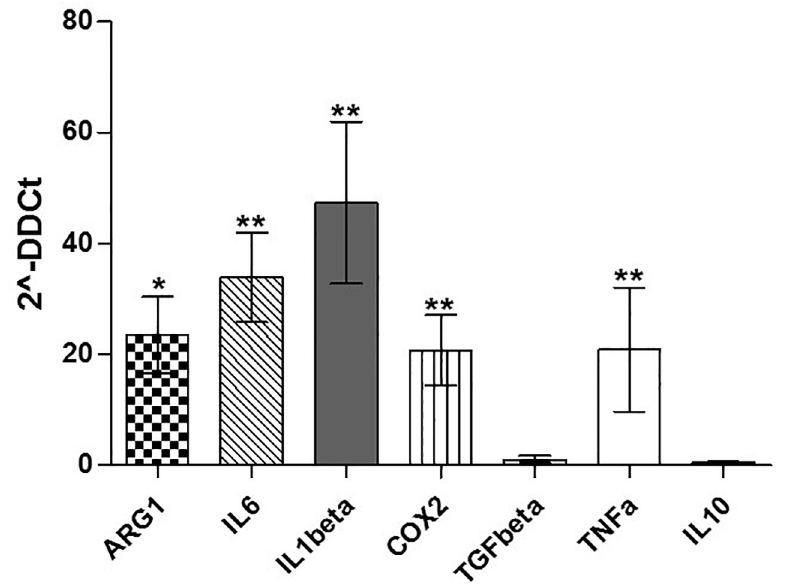
Fig 4. Expression of immunomodulatoryfactors by MSCedG-MDSC. Compared to HD-, CML-MSCedG-MDSC significantly upregulated ARG1, IL6, IL1 β ,COX2and TNF α . Calculated value of 2^- ΔΔ Ct in HD-MSCedG-MDSC was